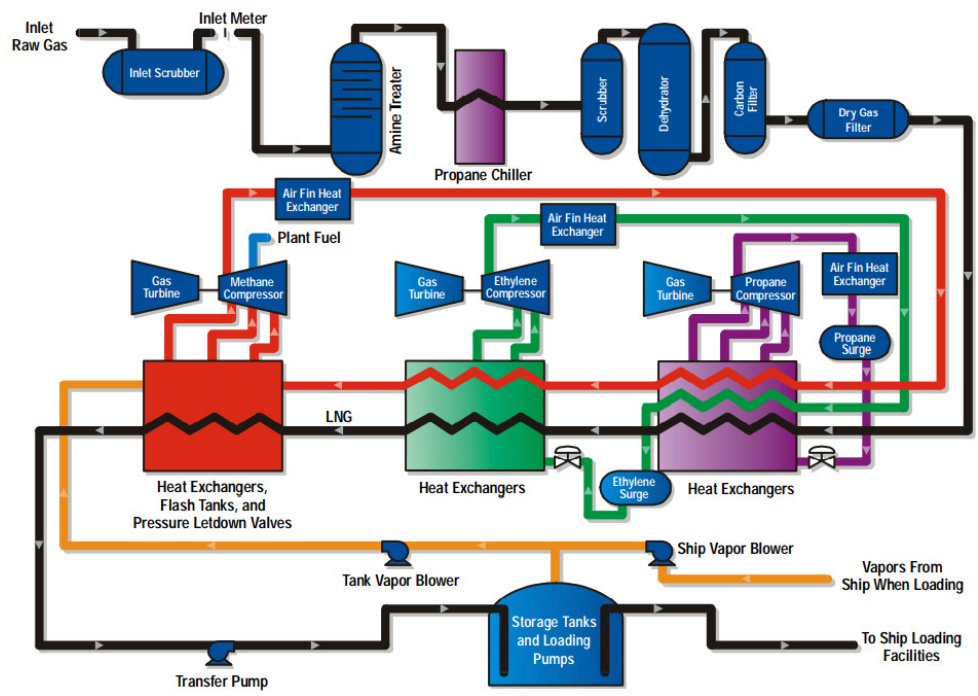
Figure 4. Phillips Optimized Cascade LNG Process Schematic [25]. Reproduced with permission from Elsevier (license number